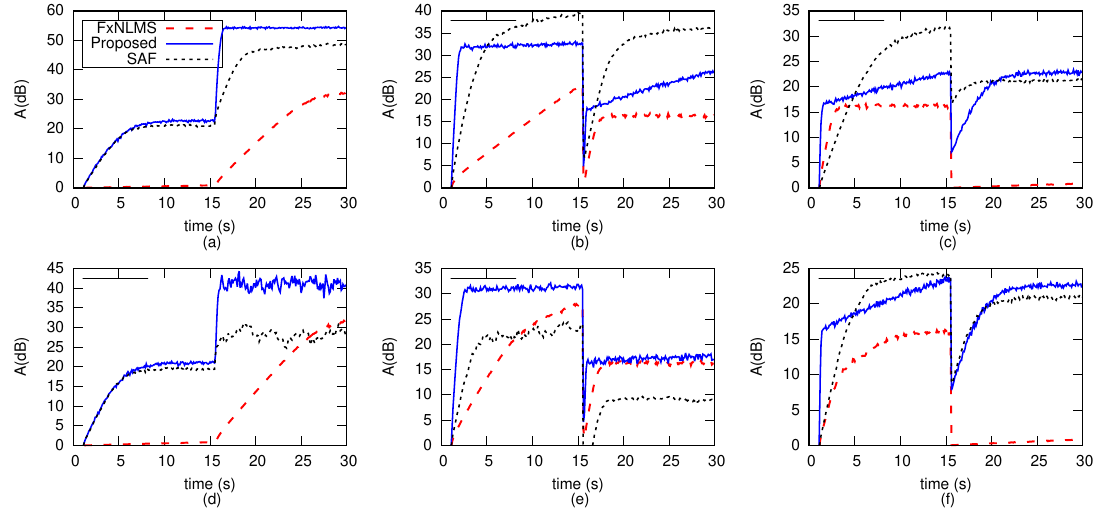
Figure 14. Test case 5: comparison of the noise reduction achieved in an ANC system, where: ( a ) is white → multi-tonal noise and plant noise ratio is 60 dB; ( b ) is multi-tonal → mono-tonal noise and plant noise ratio is 60 dB; ( c ) is mono-tonal → white noise and plant noise ratio is 60 dB; ( d ) is white → multi-tonal noise and plant noise ratio is 10 dB; ( e ) is multi-tonal → mono-tonal noise and plant noise ratio is 10 dB; ( f ) is mono-tonal → white noise and plant noise ratio is 10 dB; The control filter length is L =